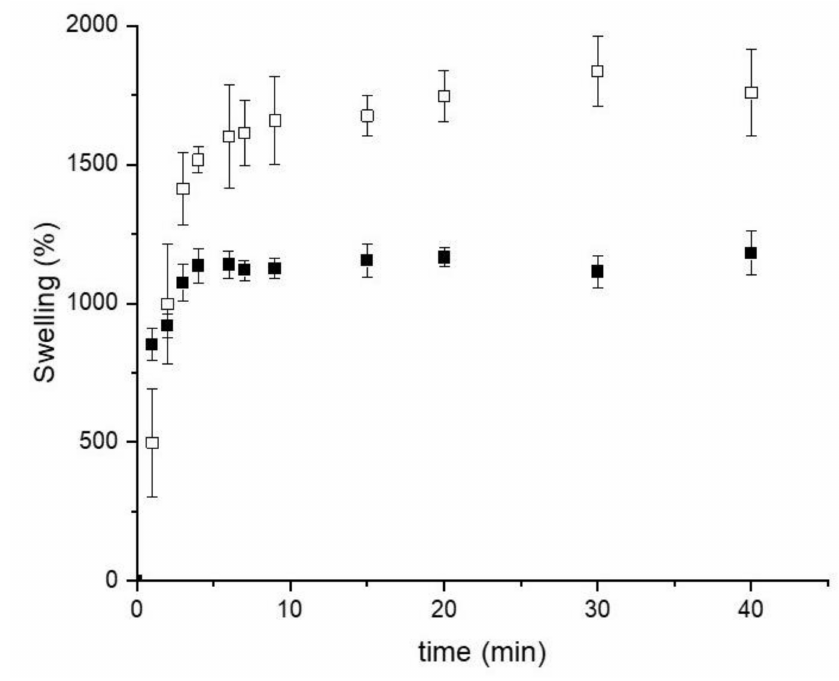
Figure 4. Swelling curves of ( (cid:3) ) CN25; ( (cid:4) ) CN25M, performed in PBS pH